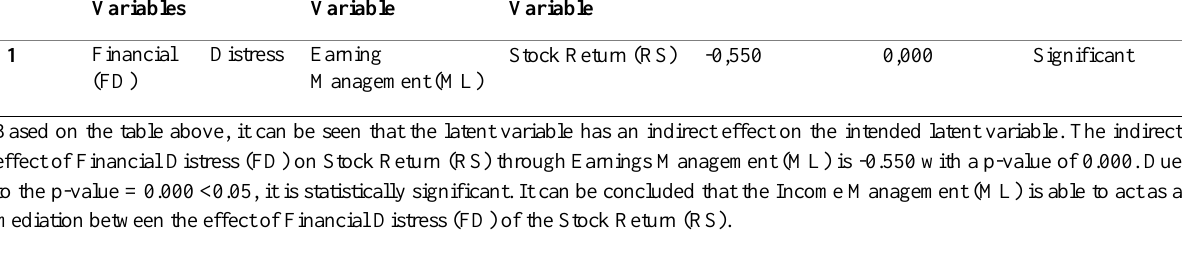
Table 4: Testing Mediation Variables Model 2 (Springate)